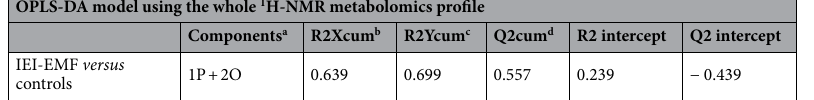
Table 2. Statistical parameters for OPLS-DA model. a The number of Predictive and Orthogonal components used to create the statistical models. b,c R2X and R2Y indicated the cumulative explained fraction of the variation of the X block and Y block for the extracted components. d Q 2 cum values indicated cumulative predicted fraction of the variation of the Y block for the extracted components. *R2 and Q2 intercept values are indicative of a valid model.